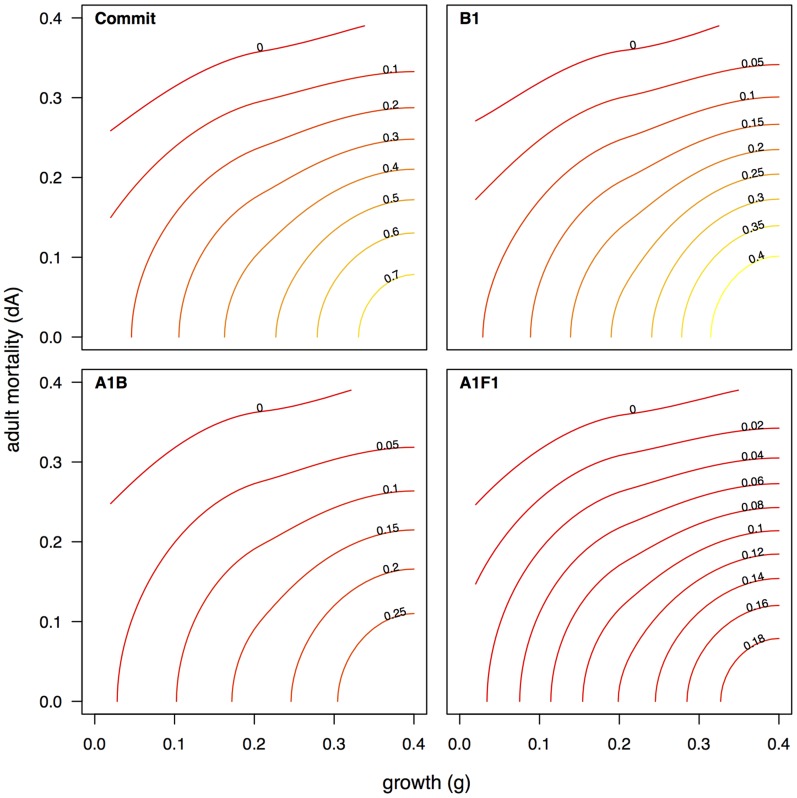
Contour plots for four IPCC climate-change scenarios (Commit, B1, A1b, and A1F1) showing the relationship between adult mortality (dA) versus growth rate (g) with the contours displaying the proportional coral cover.Contour plots were created by using a Loess smoother with average coral cover as the response variable, and g and dA as the predictors. Coral cover is greatest when growth rate is high and mortality is low. Increasingly severe bleaching mortality (i.e., as occurs in IPCC scenario A1F1) results in lower coral cover for a given combination of adult mortality and coral growth.